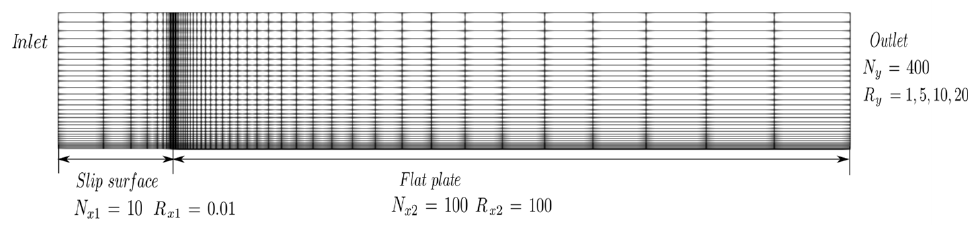
Figure 3. Mesh for turbulence flow over a flat plate. N is the number of cells and R is the cell expansion ratio in each direction.